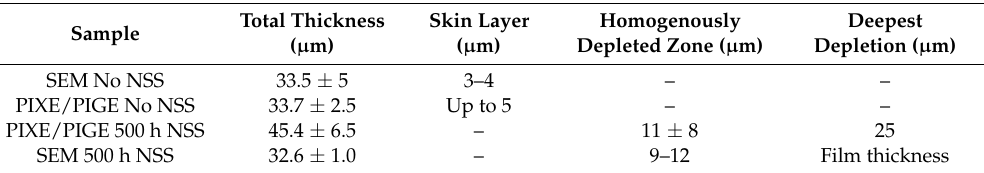
Table 4. Characteristic thickness of Li-depletion zones in